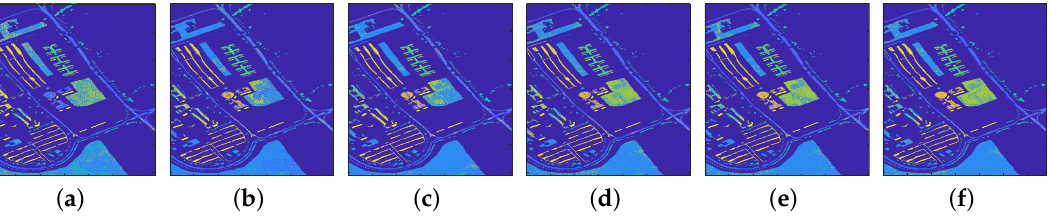
Figure 10. SVM classification maps of using the ten bands selected by different methods from the Pavia University dataset. ( a ) MVPCA ( b ) LCMVBCC ( c ) LCMVBCM ( d ) ECA ( e ) OPBS ( f ) MRMR.